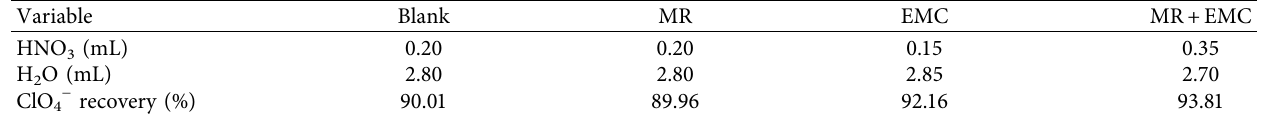
Table 4: Optimal perchlorate recovery from MR with EMC, using